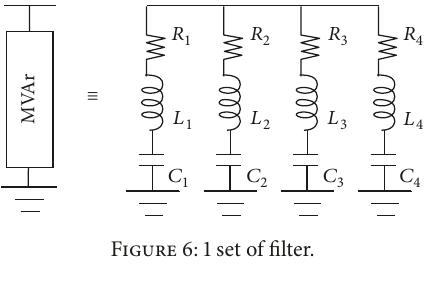
Figure 6: 1 set of